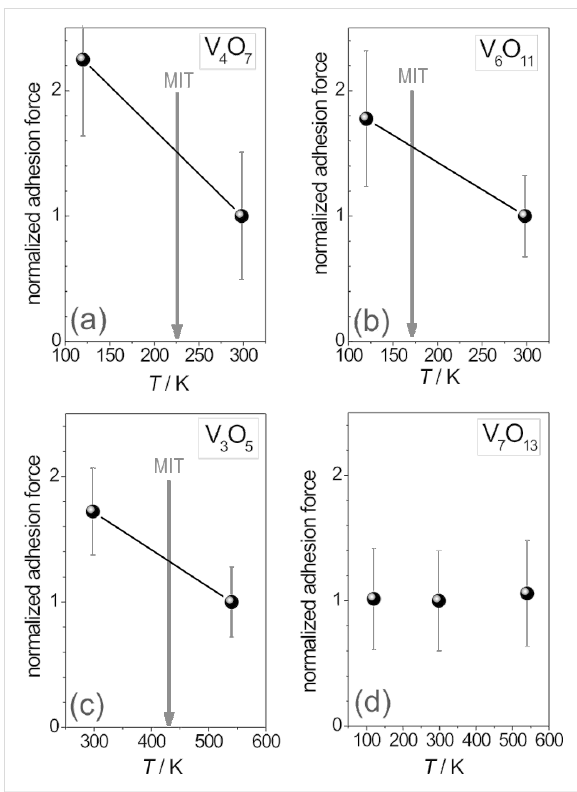
Figure 5: Summary of the mean values of the adhesion forces for all investigated Magnéli phases above and below the MIT temperature. Error bars represent the standard deviations. Each data point comprises reproducible measurements at 50 to 80 different spots. Values are normalized to facilitate comparison between different samples. All measurements on the same sample were performed with the same